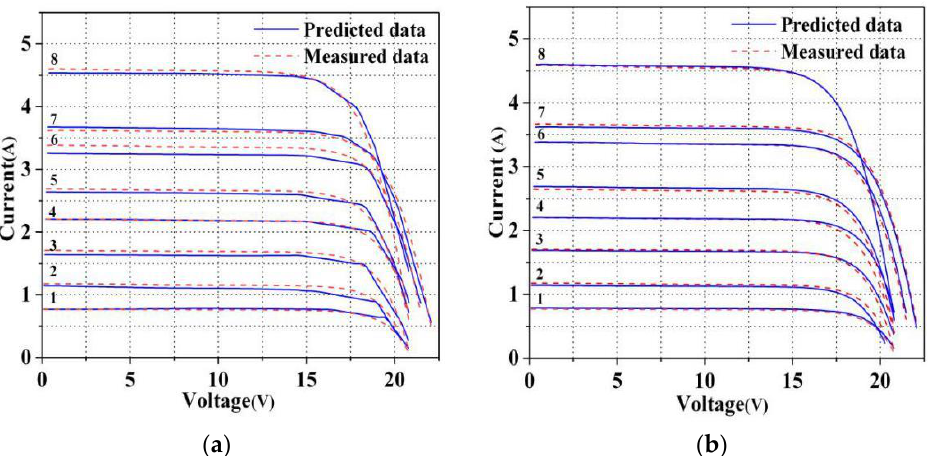
Figure 5. The fitting effect of I–V curves. ( a ) Linear fitting effect of MLP mode; ( b ) Linear fitting effect of CNN model. Table 2. RMSE and MAE of I–V curves.